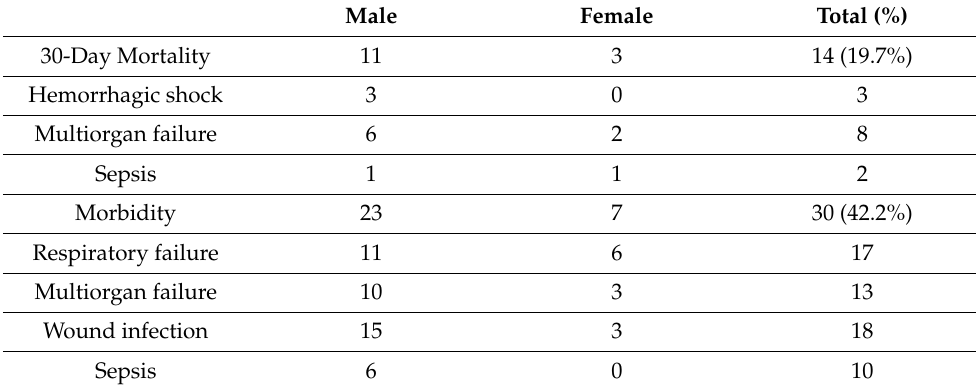
Table 2. Morbidity/mortality data in our